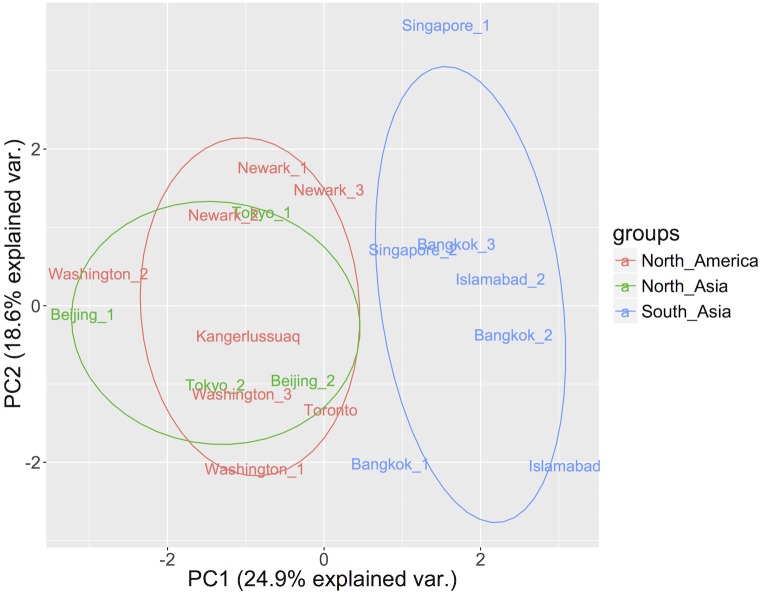
Principal component analysis (PCA) of the airplane sewage viral community composition.Log10 transformed viral reads per million (VRPM) values for the 12 most abundant virus families were used as input. The individual samples are colored according to their assigned region.